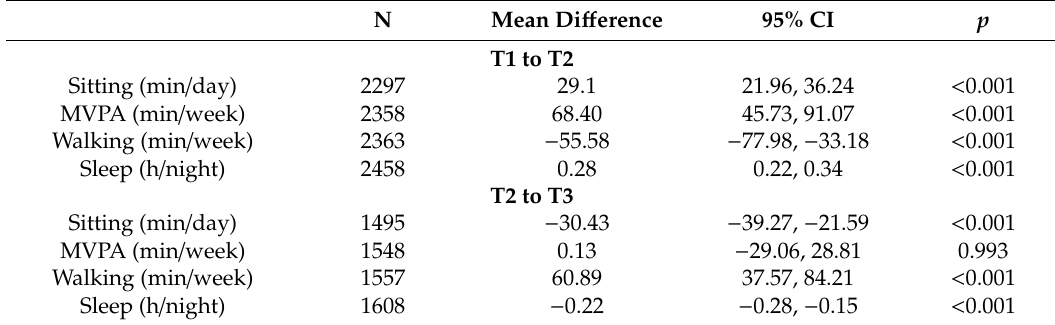
Table 3. Change in 24-hour movement behaviors over